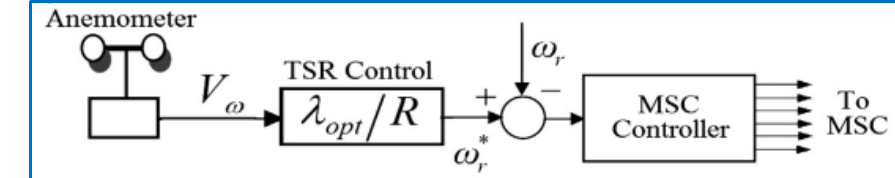
Figure 5. TSR based MPPT.